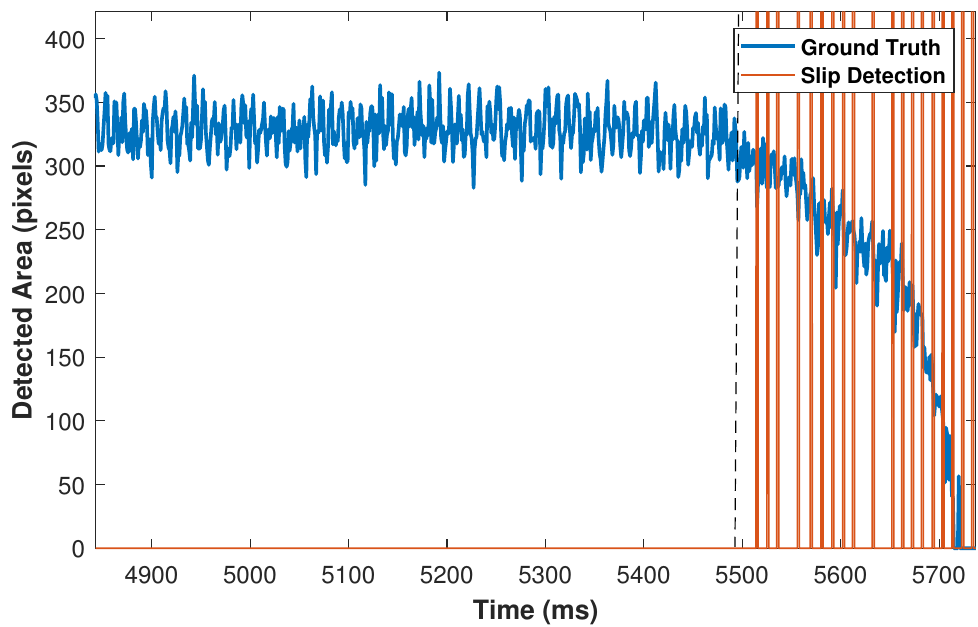
Figure 12. Ground truth: blue, start of incipient slip: dotted line, TP incidents: red lines, FN incidents: abnormal gap after dotted